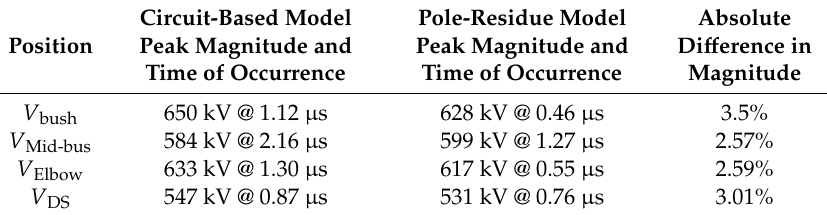
Table 4. Comparison of maximum peak voltage around